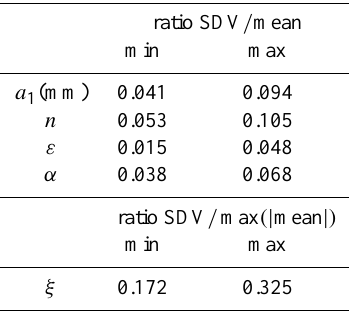
Table 2. Ranges of values (in the grid) of the ratio SDV / mean for a 1 , n , ε and α and of ratio SDV / max ( | mean | ) for ξ